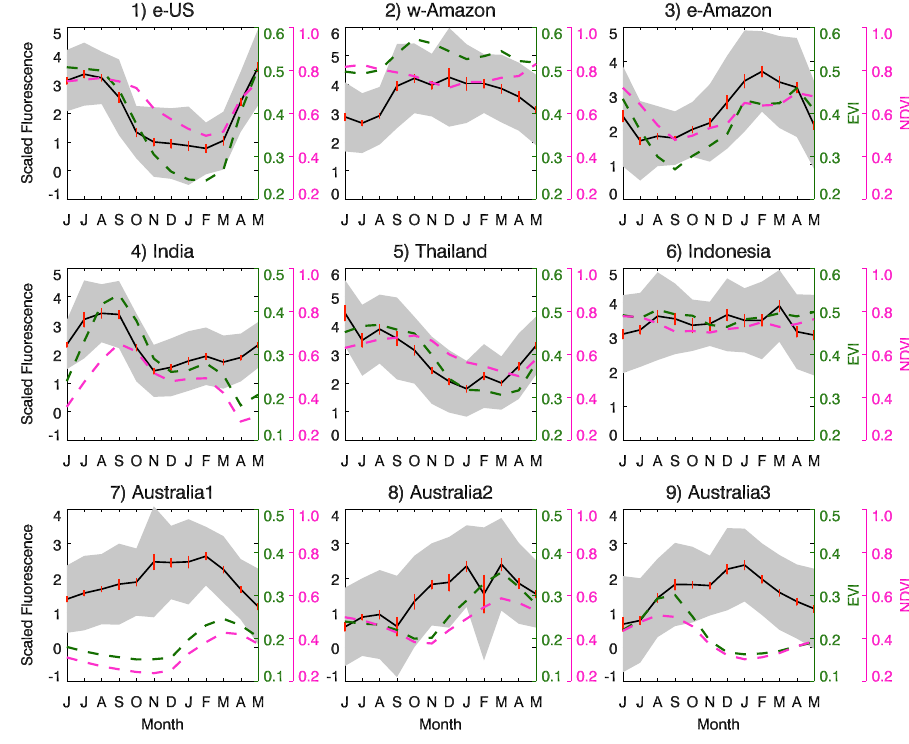
Fig. 13. Similar to bottom panel of Fig. 12 but derived from the GOSAT S polarization data.